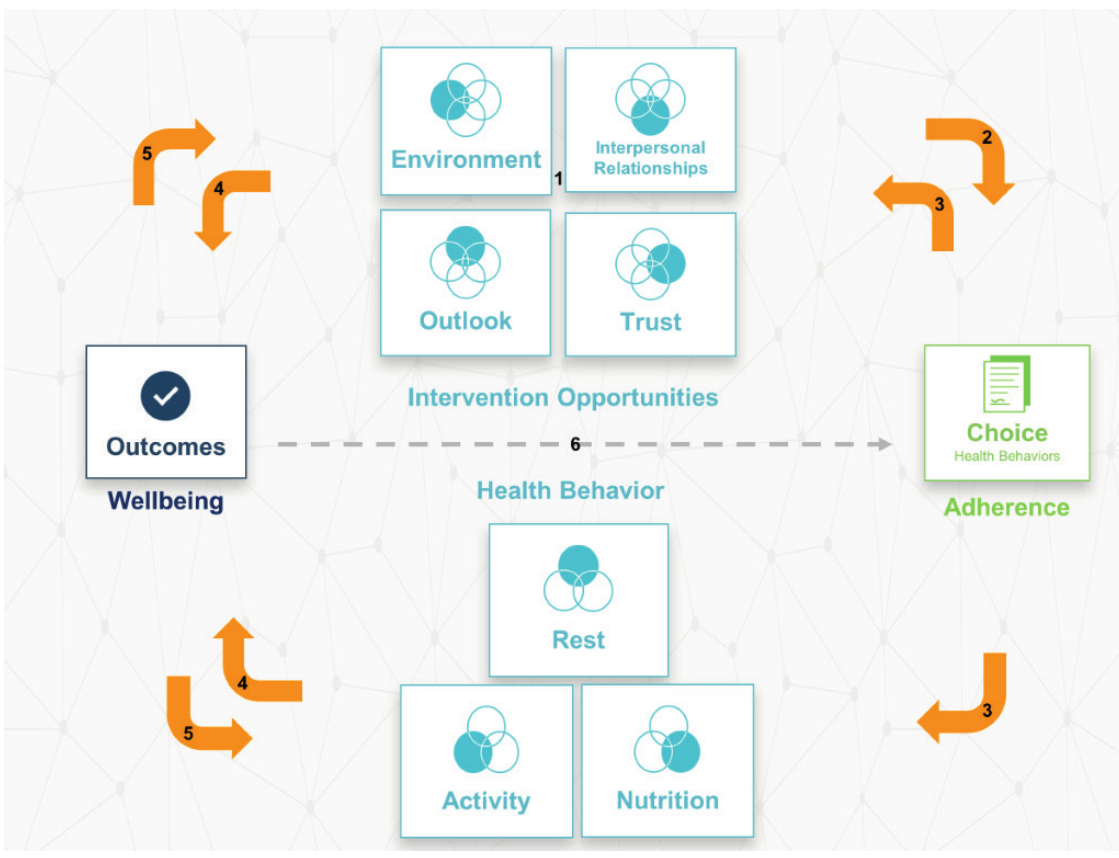
Figure 1. The CREATION Wellness model.